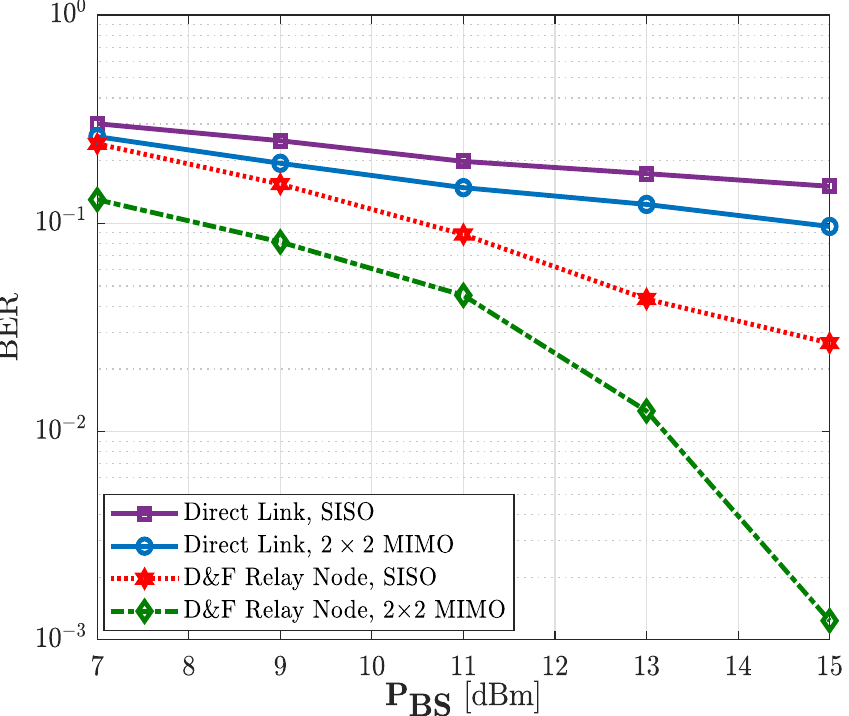
Figure 17. Bit error rate (BER) vs. transmission power of the gnodeB (P BS ) of the relay node co- operative 5G network;